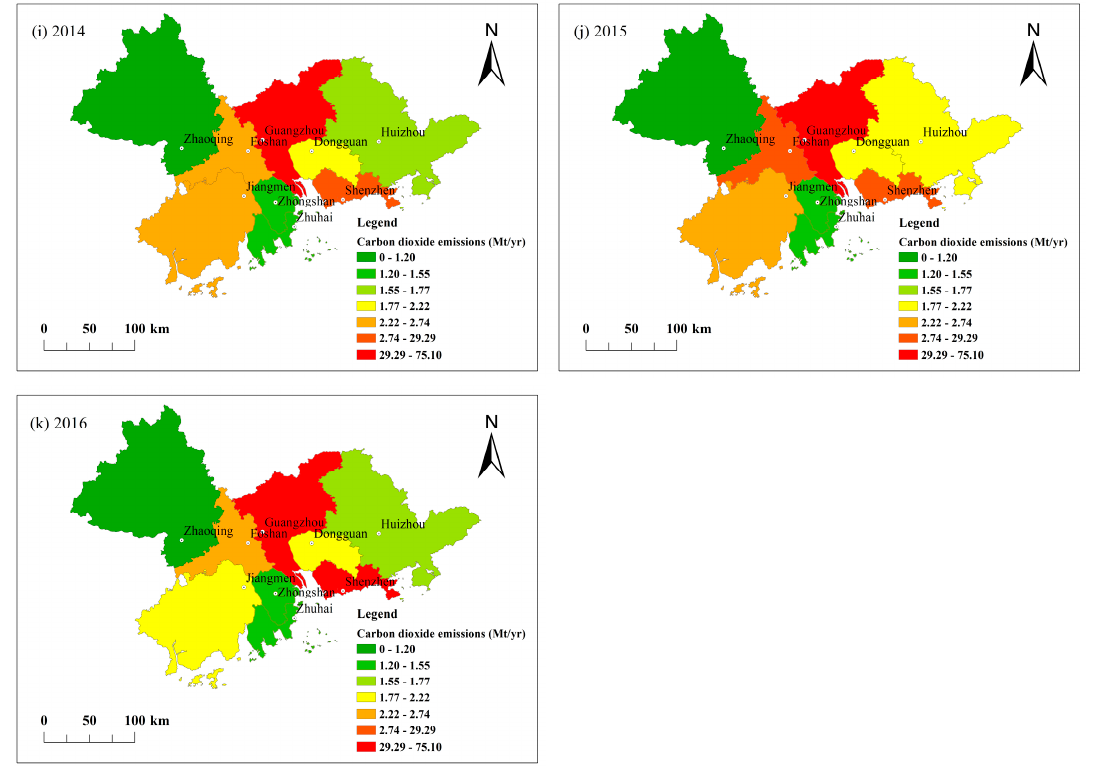
Figure 10. Spatiotemporal patterns of CO 2 emission of the Pearl River Delta, 2006 – 2016.